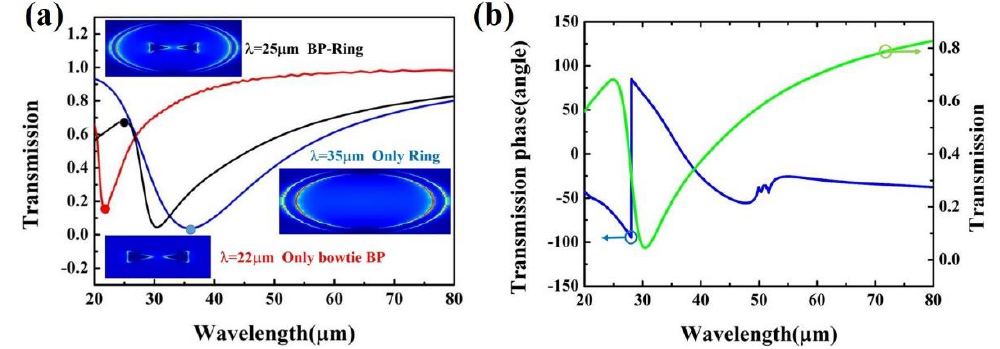
Figure 2. ( a ) The transmission spectra through the proposed structure composed of Au ring only (blue), bowtie BP (red) and both the Au ring and the bowtie BP (black). Insets: electric field intensity distributions. ( b ) Transmission phase (blue) of the proposed structure. Transmission spectra (green) is the transmission spectra of the proposed structure composed of both Au ring and bowtie BP in figure a. Please note that in the electric field distribution of the inset, the ring looks like an elliptical ring, which is caused by the difference in the step length of the X-axis and the Y-axis.